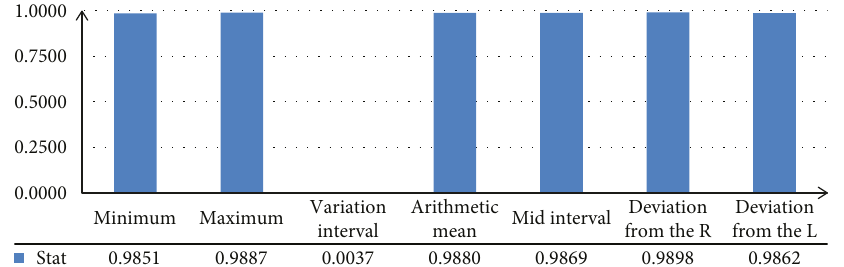
Figure 5: Operational availability statistics for period I.